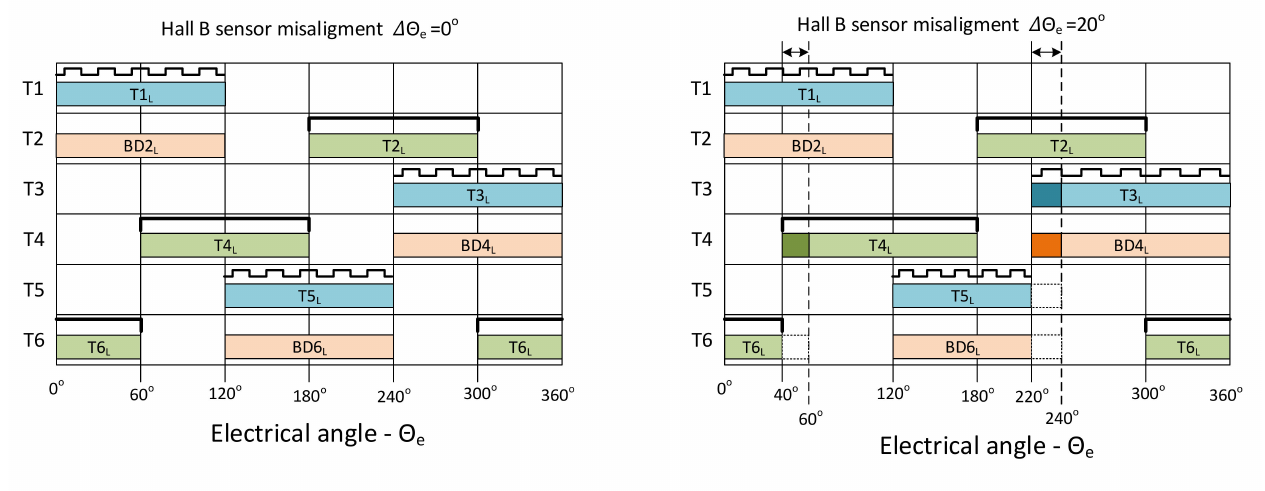
Figure 8. Losses in individual elements of the unipolar-controlled BLDC motor inverter as a function of the electric angle, TXL—transistor X losses, BDXL—body diode losses of TX transistor.